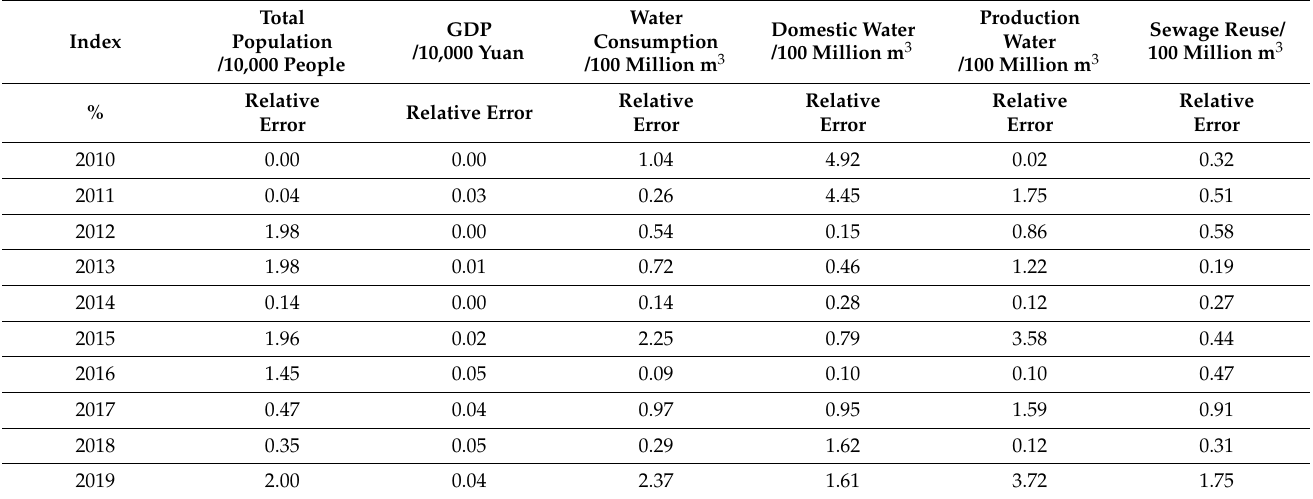
Table 5. Results of the analysis of the effectiveness of the SD simulation